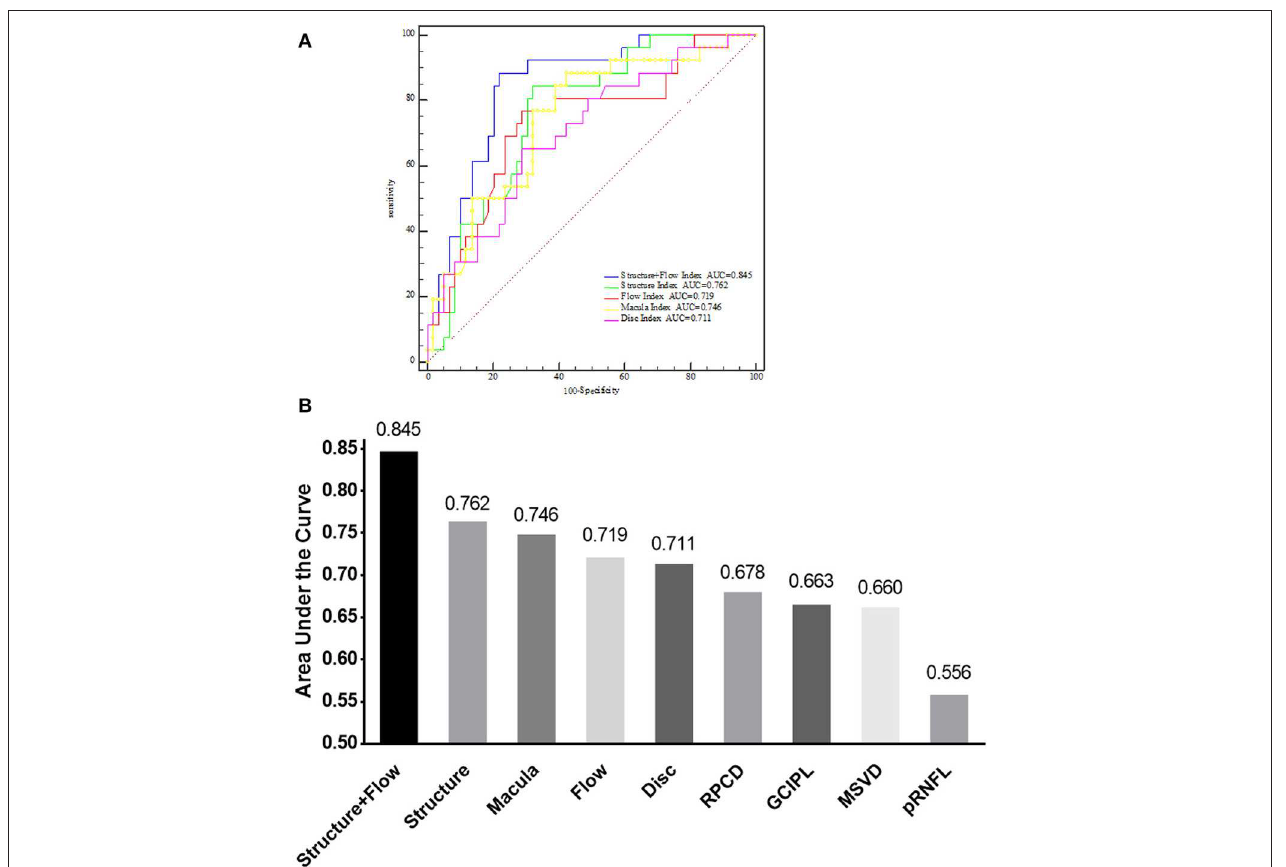
FIGURE 4 | AUC of different indices for discriminating between NMOSD–ON and HC. (A) Comparison of the Structure + Flow index, Structure index, Flow index, Macula index, and Disc index by receiver operating characteristic curves analysis for discriminating between NMOSD–ON and HC eyes. (B) AUC of nine different parameters for discriminating between NMOSD–ON and HC eyes. NMOSD–ON, neuromyelitis optica spectrum disorders without a history of optic neuritis. NMOSD + ON, neuromyelitis optica spectrum disorders with a history of optic neuritis; HC, healthy control; AUC, area under the curve; GCIPL, ganglion cell layer and inner plexiform layer; pRNFL, peripapillary retina nerve fiber layer; MSVD, macular superficial vessel density; RPCD, radial peripapillary capillary density. Structure, a combination of GCIPL and pRNFL; Flow, a combination of MSVD and RPCD; Structure + Flow, a combination of MSVD, RPCD, pRNFL, and GCIPL; Disc, a combination of RPCD and pRNFL; Macular, a combination of MSVD and GCIPL.